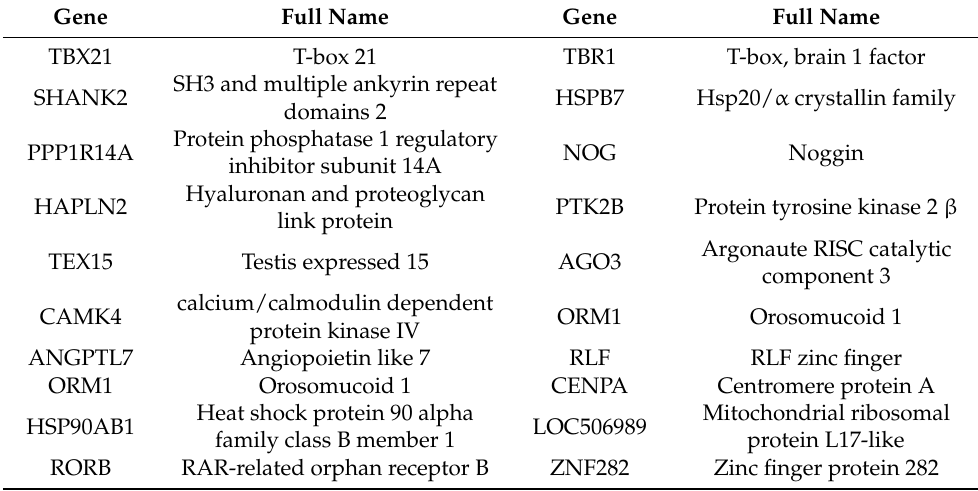
Table 1. Genes validated by